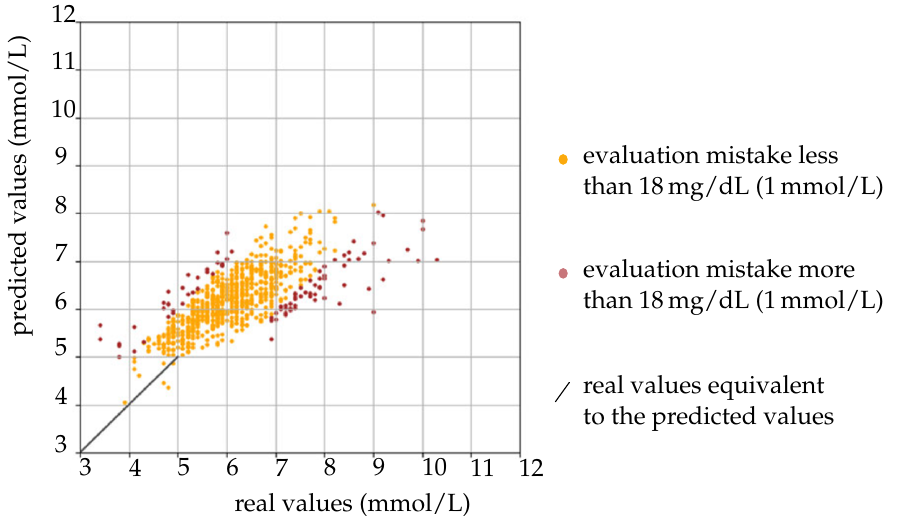
Figure 13. Correctness of real and predicted values of BGmax (Adapted from Ref. [114]). Table 7. Performance comparison of previous publications regarding the iAUC120